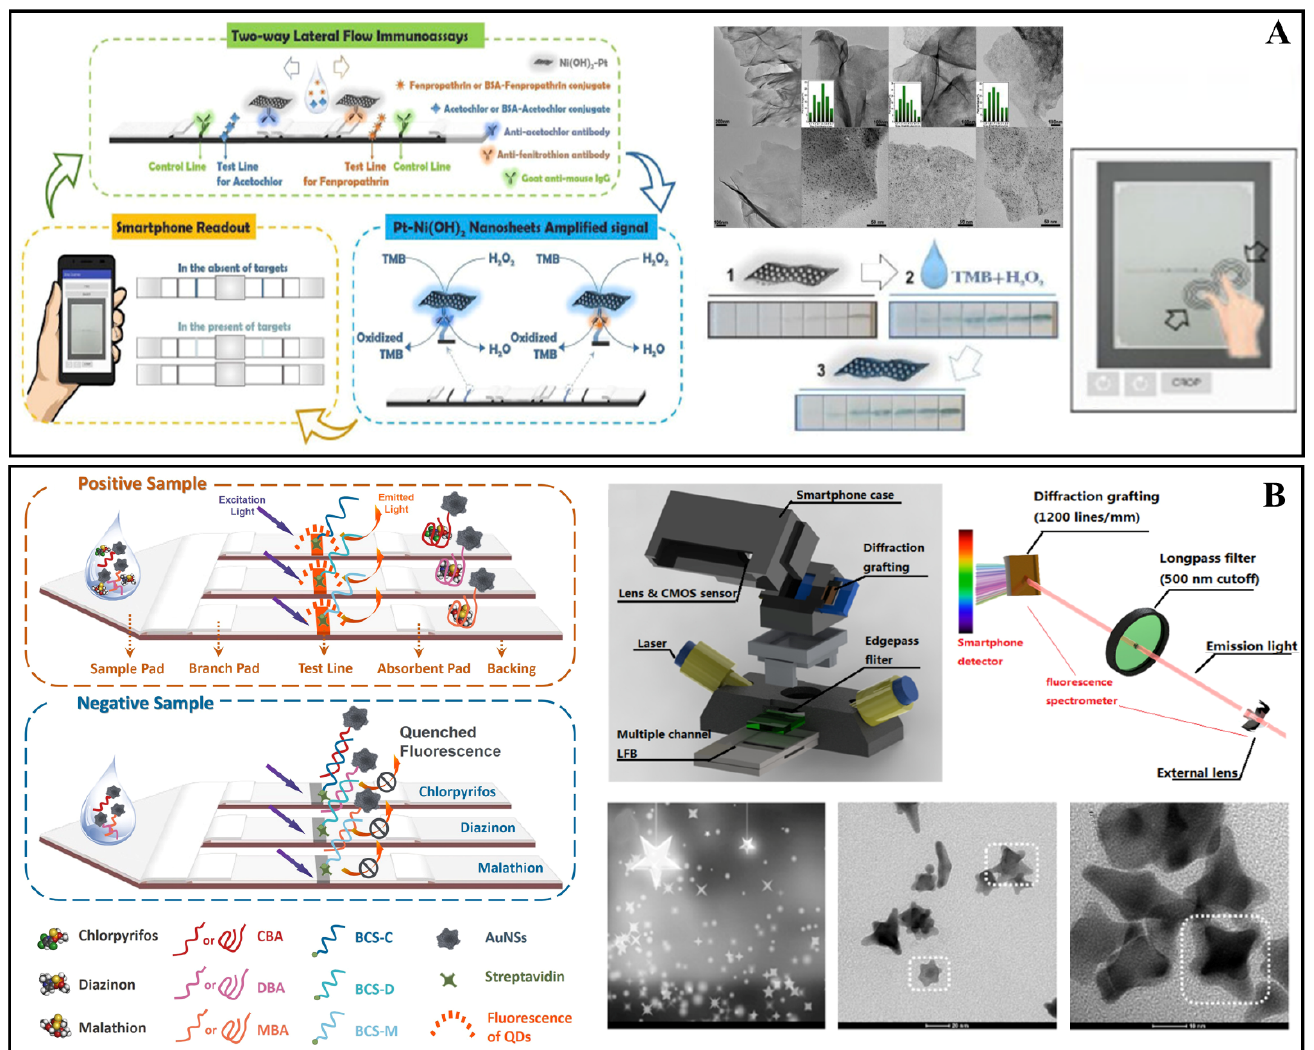
Figure 11. ( A ) Portable system for rapid assays of herbicide and insecticide residues, featuring schematic diagram of two-way LFI for detection of acetochlor and fenpropathrin. Transmission electron microscopy (TEM) images of as-prepared Ni(OH) 2 nanosheets, and LFI images during the reaction. Reprinted with permission from Cheng et al. [75]. Copyright 2019, Elsevier. ( B ) Development of a fluorescent aptamer-based lateral flow biosensor (apta-LFB) with design: positive and negative samples for the pesticides chlorpyrifos, diazinon, and malathion. Reprinted with permission from Chen et al. [44]. Copyright 2018,